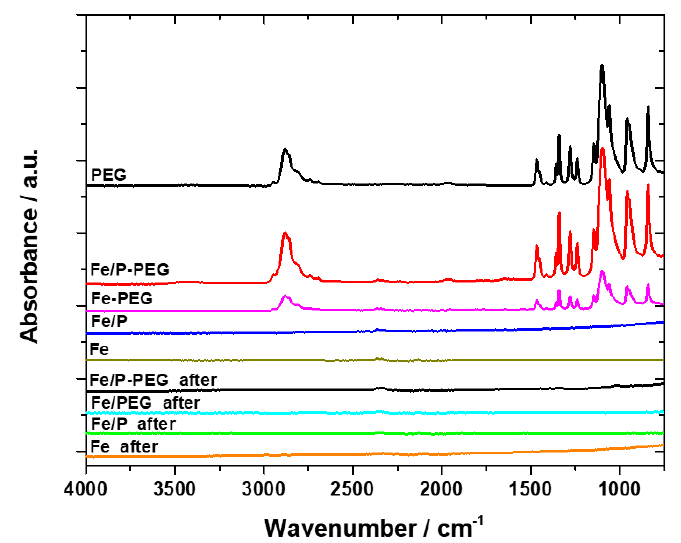
Figure 8. FT-infrared spectra of PEG and iron-based foams (Fe, Fe-PEG, Fe/P, and Fe/P-PEG) before and after 1-week immersion in Hanks’ solution.